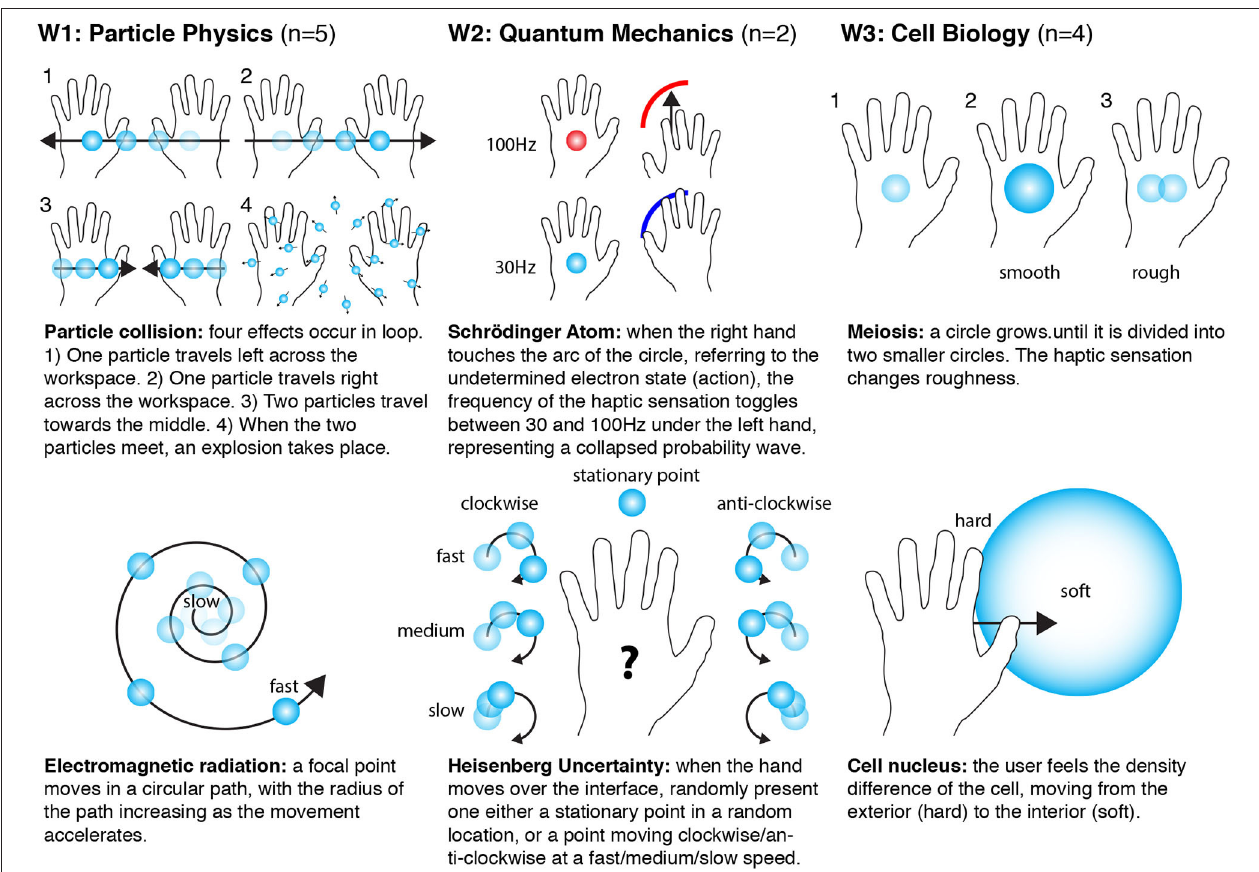
FIGURE 2 | Design of the six mid-air haptic probes used in the three workshops. In W1, we presented two designs representing concepts in particle physics: particle collision and electromagnetic radiation. In W2, we presented two designs representing concepts in quantum mechanics: the Schrödinger Atom and Heisenberg Uncertainty. In W3, we presented two designs representing concepts in Cell Biology: Meiosis and a Cell Nucleus.